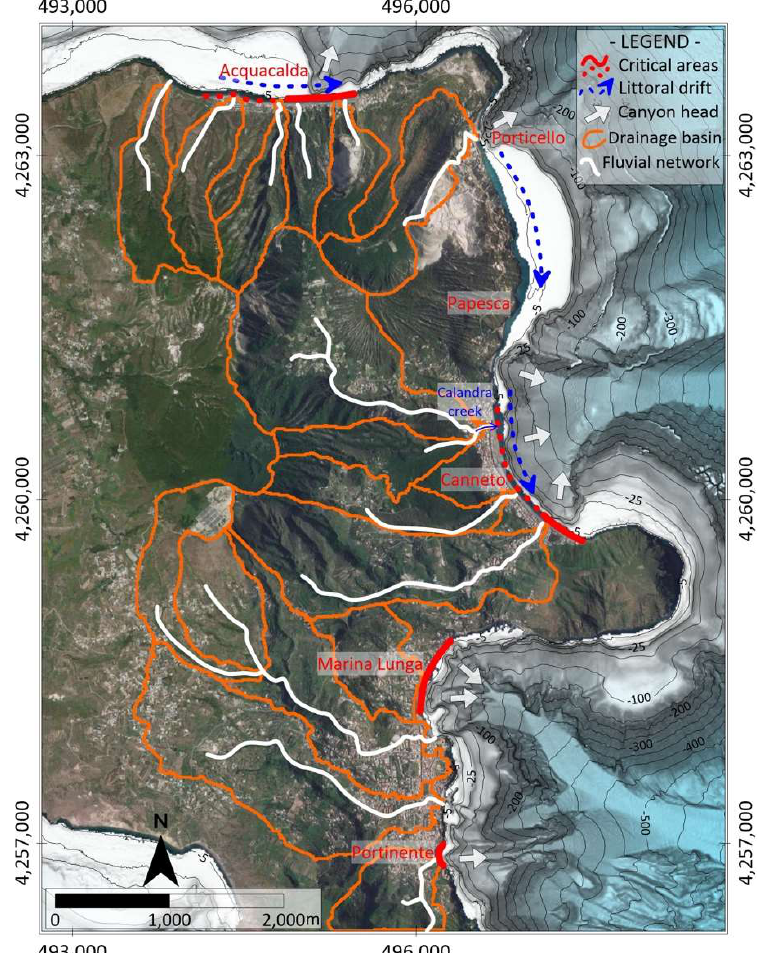
Figure 13. Sketch of drainage basins and fluvial network in the eastern and north-eastern sectors of Lipari Island. Main coastal areas critical for coastal erosion and flooding are indicated with red lines (dashed red line indicates sectors that are “potentially critical”; they are maintained in a precarious equilibrium state by man-made activities, such as defense interventions). The location of the active canyon heads located in the nearshore and the direction of the main littoral drift are also indicated.